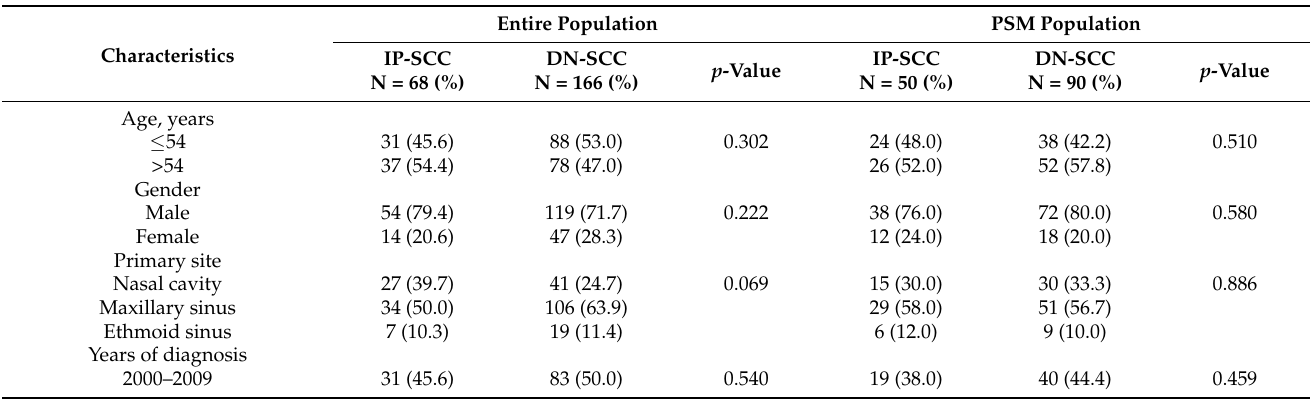
Table 1. Comparison of baseline characteristics of inverted papilloma–associated squamous